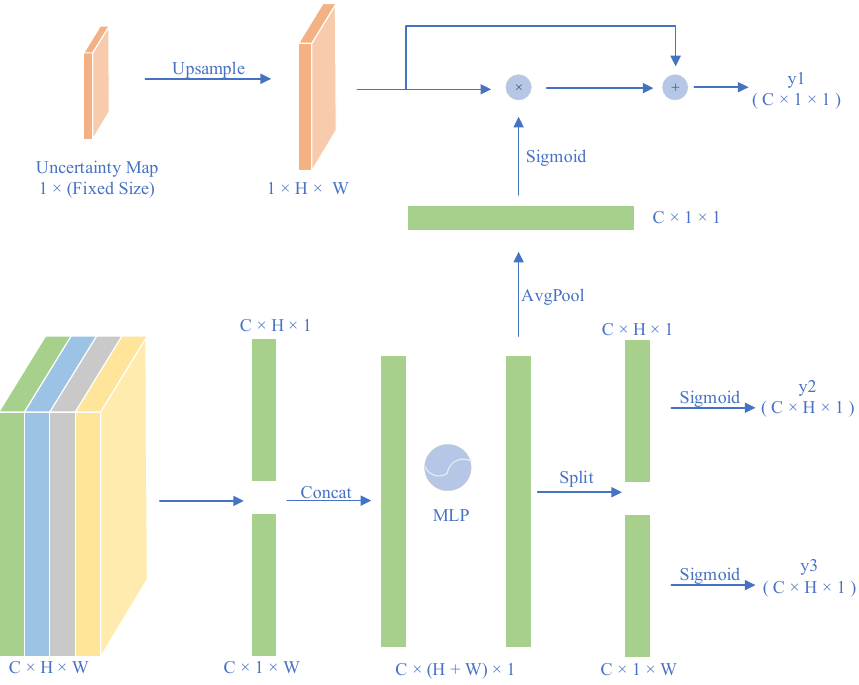
Figure 4. Architecture of the attention module.